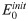
Diagrams of the Heinrich and Huang-Ferrell Model.A linear signaling cascade is a biochemical network where the product of one reaction acts as an enzyme for a reaction downstream. (A) The Heinrich model captures the basic essence of such an architecture. For time t < 0, the receptor, E0 receives a stimulus with strength E0init. E0 then converts M0 to M0p. M0p then converts M1 to M1p, and M1p converts M2 to M2p. The concentration of M2p is considered the output response. After the system reaches a steady-state, at time t = 0, the stimulus is immediately removed, and the system then settles into a deactivated state. (B) The Huang-Ferrell is a more complicated model that explicitly includes the phosphatase at each layer and assumes mass-action kinetics. The second and third layer also assume double-phosphorylation events are needed for activation.